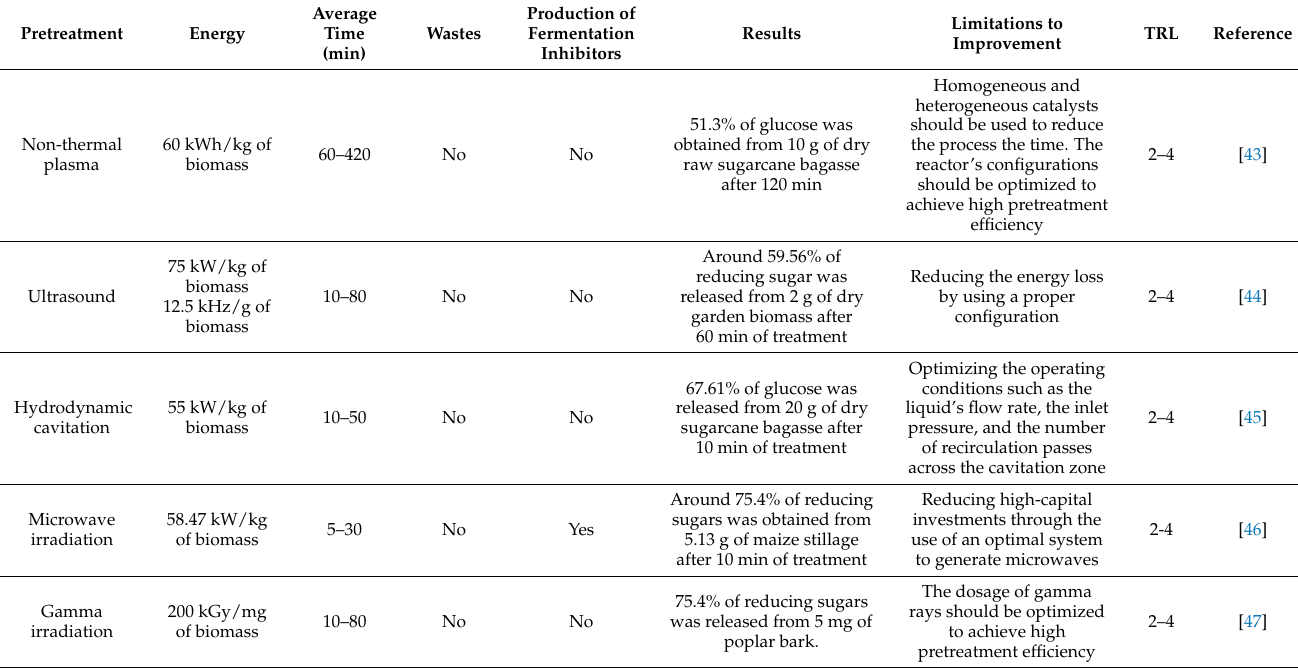
Table 2. Non-conventional